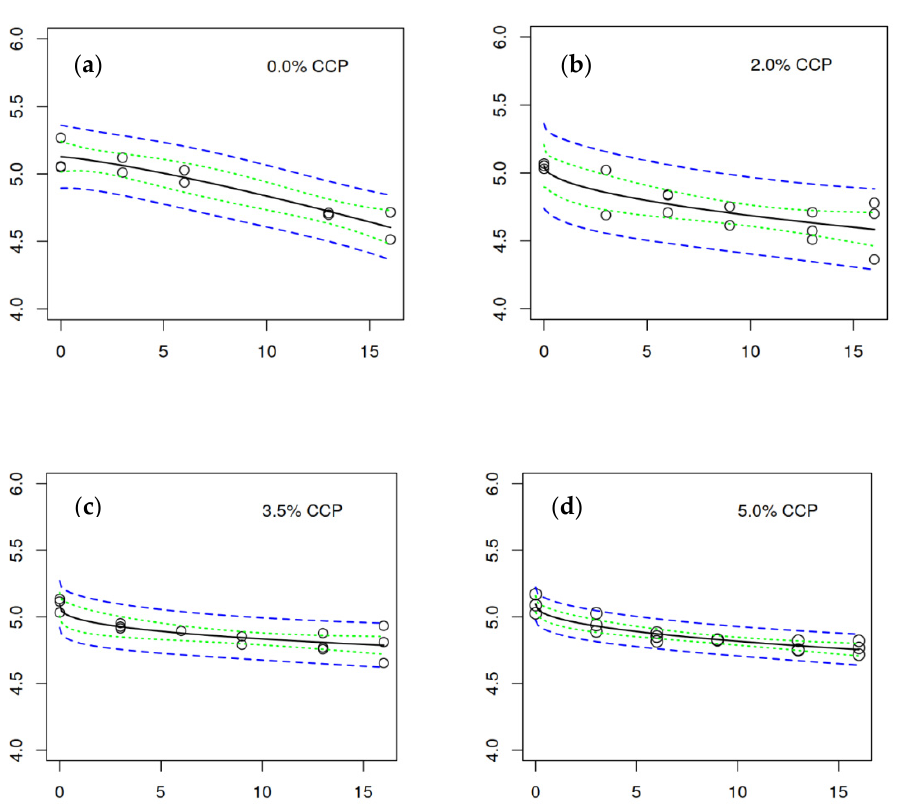
Figure 3. Weibull model fitting to experimental survival curves of S. enterica ser. Typhimurium in vacuum-packed ground beef containing different camu-camu powder (CCP) levels stored at 5 °C: 0.0% ( a ), 2.0% ( b ), 3.5% ( c ) and 5.0% ( d ). The 95% confidence intervals are displayed as green lines and the prediction intervals as blue lines. X -axis: Time (day); y -axis: Counts (log CFU/g).